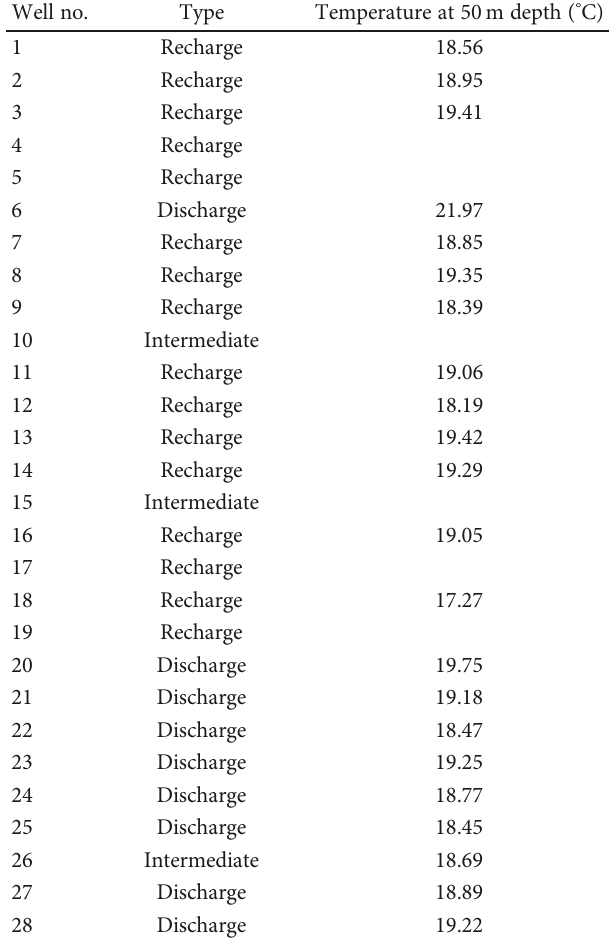
Table 2: Summary of observed temperature-depth pro fi les in Kumamoto Plain in